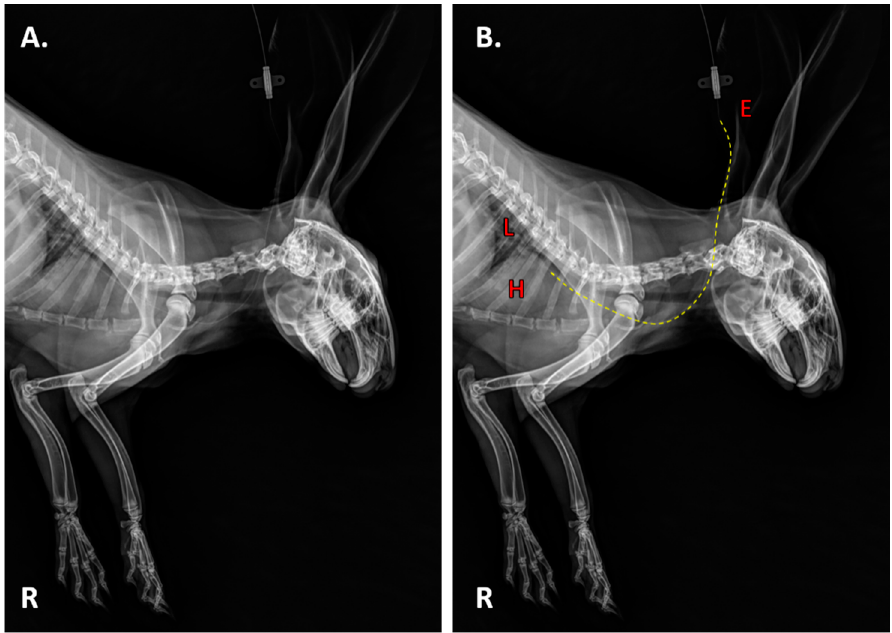
Figure 2. Lateral radiography of a rabbit with a catheter in its marginal ear veins ( A ) and its anatomical location ( B ). The discontinuous yellow line represents the catheter path. E: ear. L: lung. H: heart.